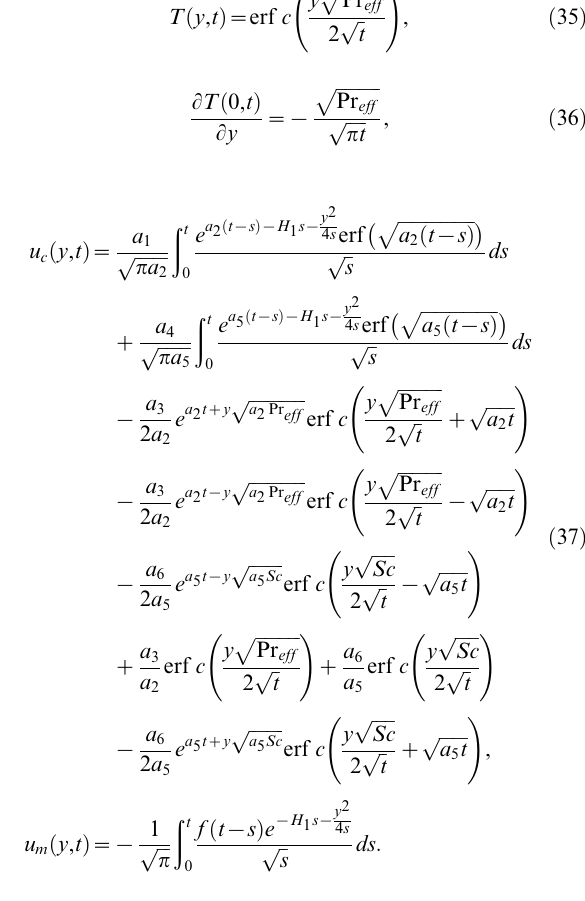
ffiffiffiffiffiffiffiffiffiffiffiffiffiffiffiffiffi a